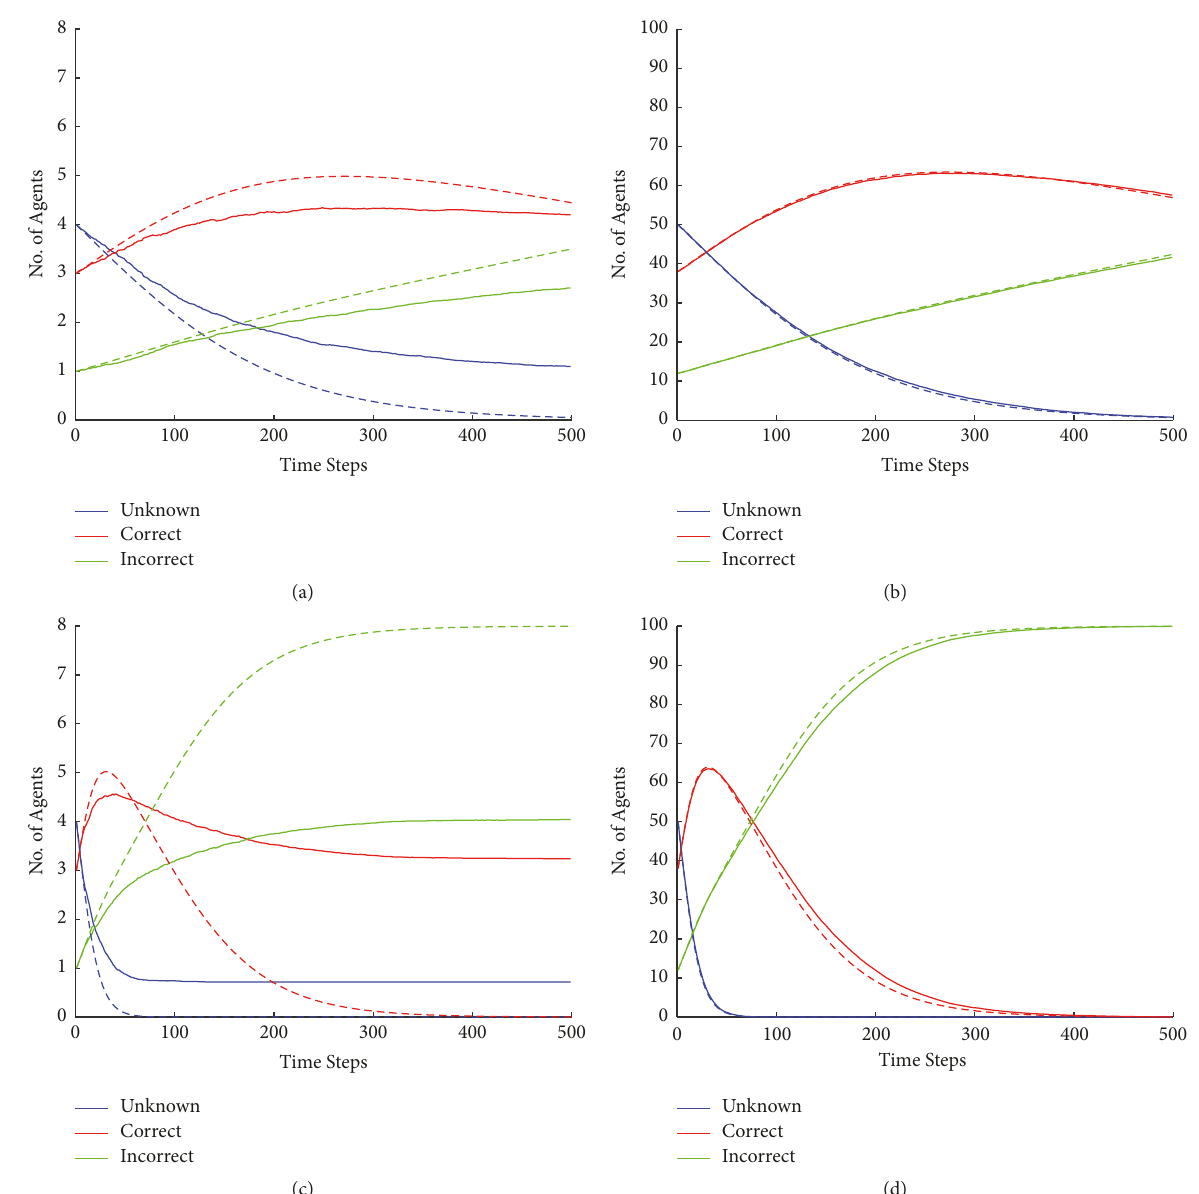
Figure 4: Dynamics in “wishful-thinking scenario” against low and high trust values with different population sizes. (a) Trust = 0.1, 𝑁 = 8 ; (b) trust = 0.1, 𝑁 = 100 ; (c) trust = 0.9, 𝑁 = 8 ; (d) trust = 0.9, 𝑁 = 100